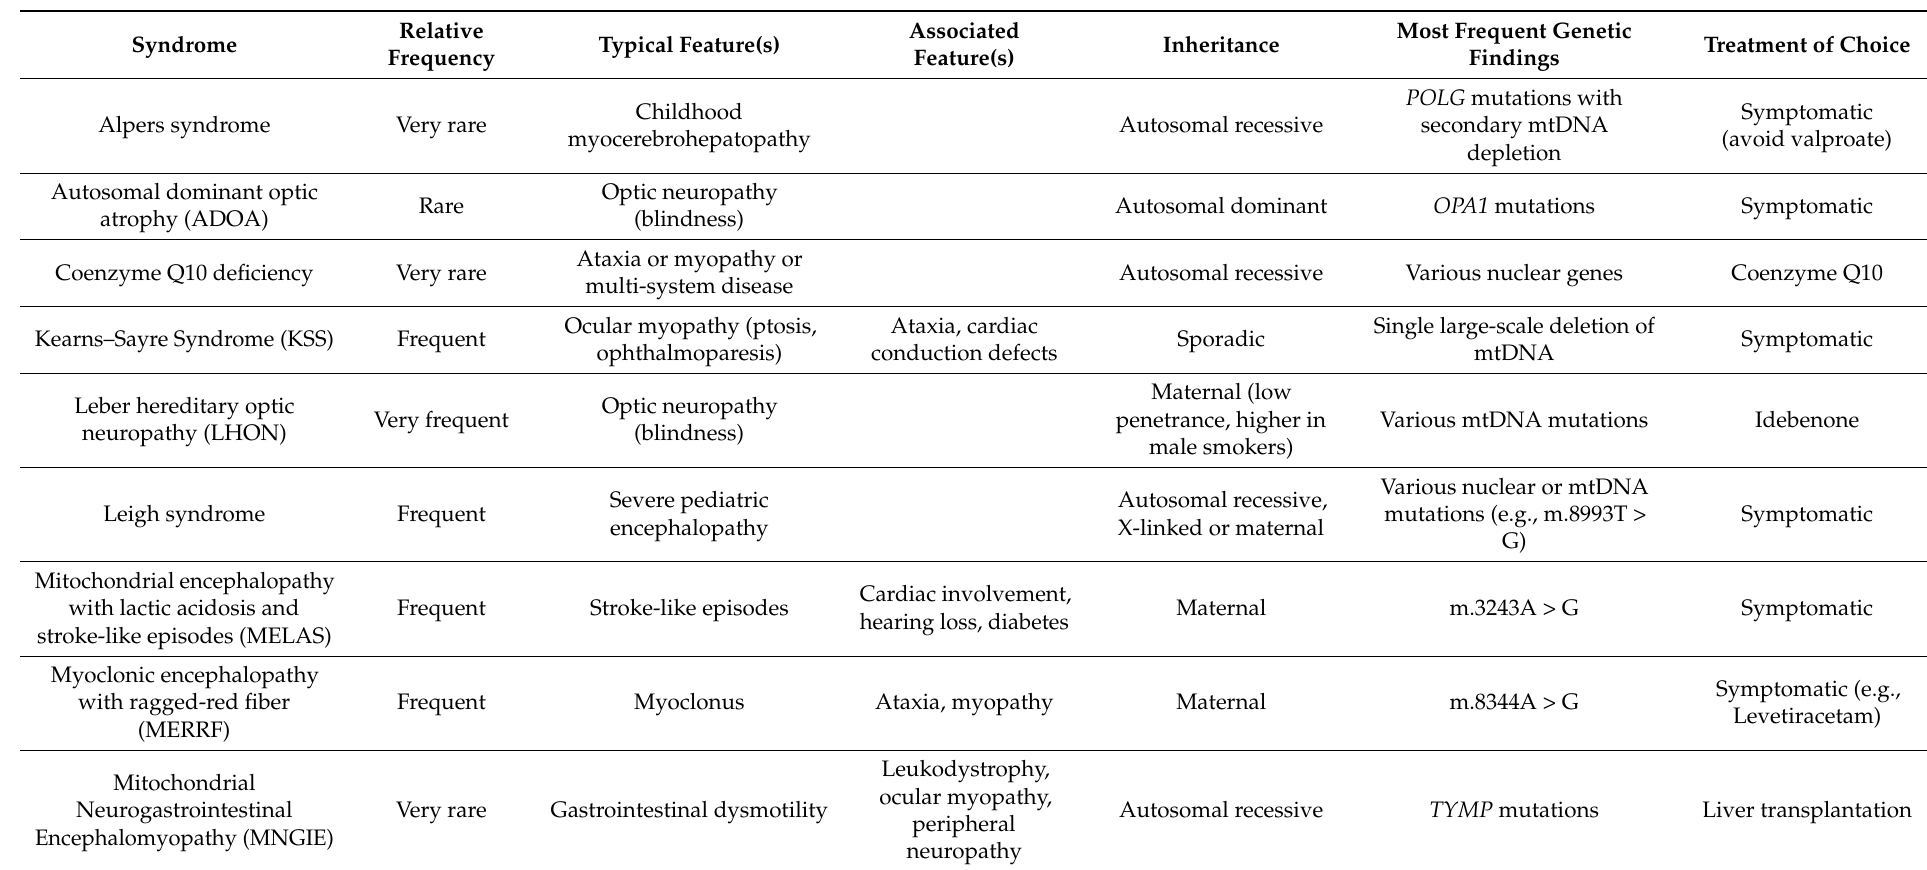
Table 2. Typical mitochondrial syndromes. Many patients do not show these full-blown clinical pictures and are affected by a variety of complex or partial pictures (myopathies, neuropathies, cardiomyopathies, encephalomyopathies, multisystemic diseases, and so on). The relative frequencies are indicative (specifically designed epidemiological studies are not available). mtDNA, mitochondrial